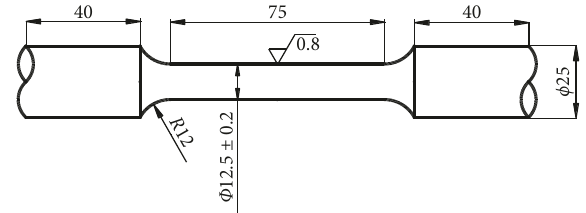
Figure 5: The size of tensile sample.